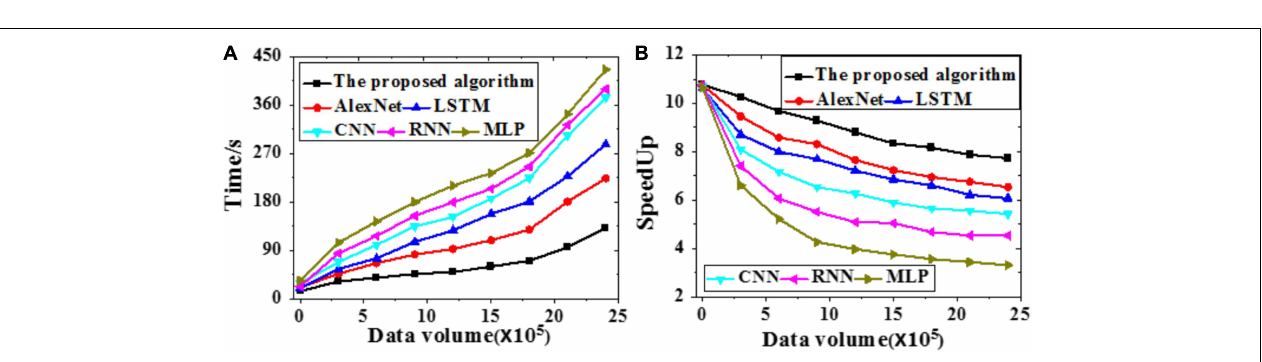
FIGURE 9 | Brain image assessment indicators of different models with iterations (A) The Jaccard coefficient; (B) DSC; (C) PPV; (D) Sensitivity.